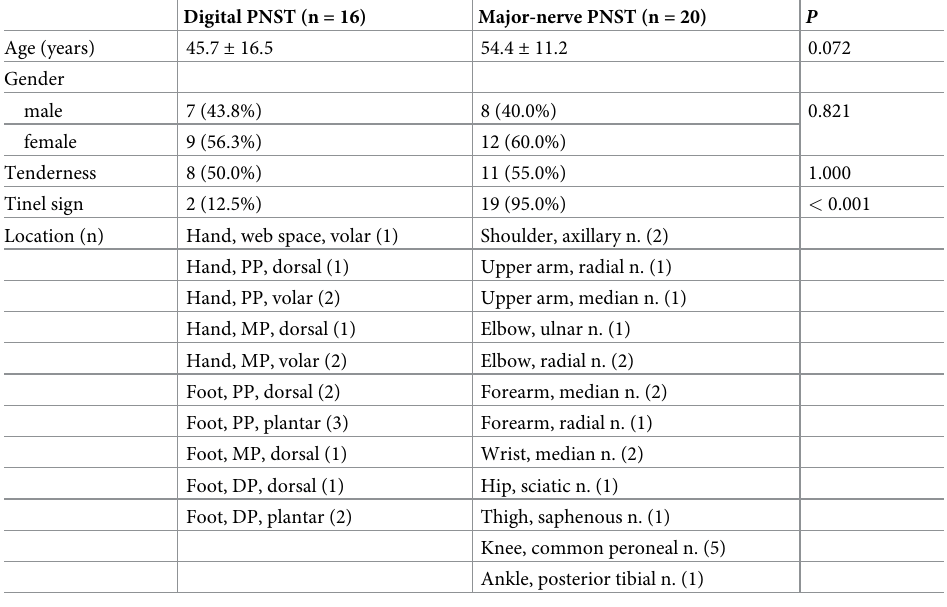
Table 1. Summary of patient characteristics and clinical